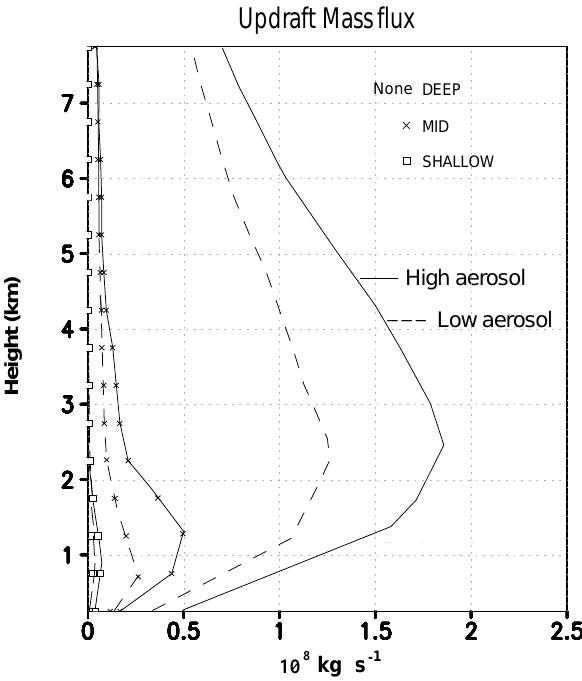
Fig. 9. Vertical distribution of time-averaged updraft mass flux for the high- and low-aerosol runs. The high- and low-aerosol runs for DEEP, MID, and SHALLOW include ice physics, though ice physics is not activated in